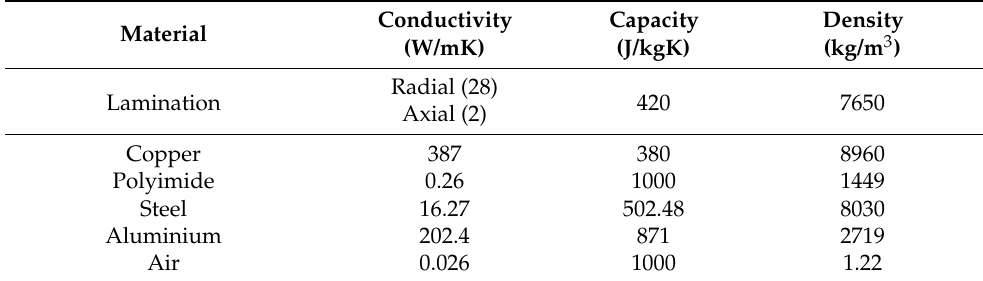
Table 7. Thermal Properties of materials.